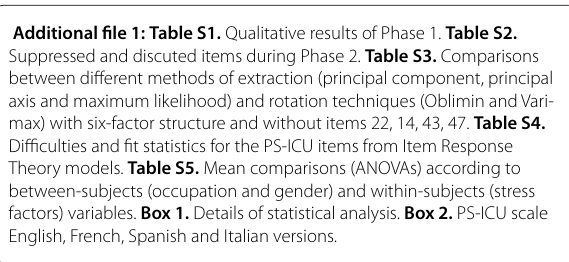
max) with six‑factor structure and without items 22, 14, 43, 47. Table S4. Difficulties and fit statistics for the PS‑ICU items from Item Response Theory models. Table S5. Mean comparisons (ANOVAs) according to between‑subjects (occupation and gender) and within‑subjects (stress factors) variables. Box 1. Details of statistical analysis. Box 2. PS‑ICU scale English, French, Spanish and Italian